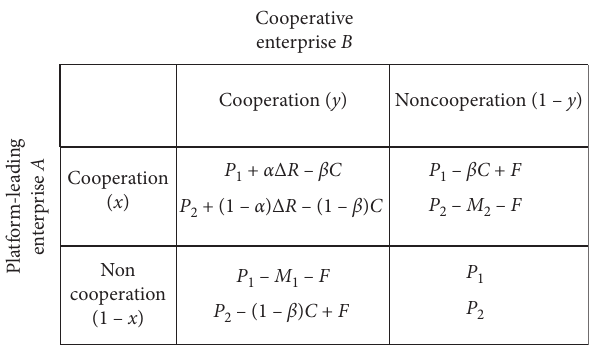
Figure 1: The payoff matrix of the two players in the evolutionary game. Table 1: The specifications of variables in the tripartite evolutionary